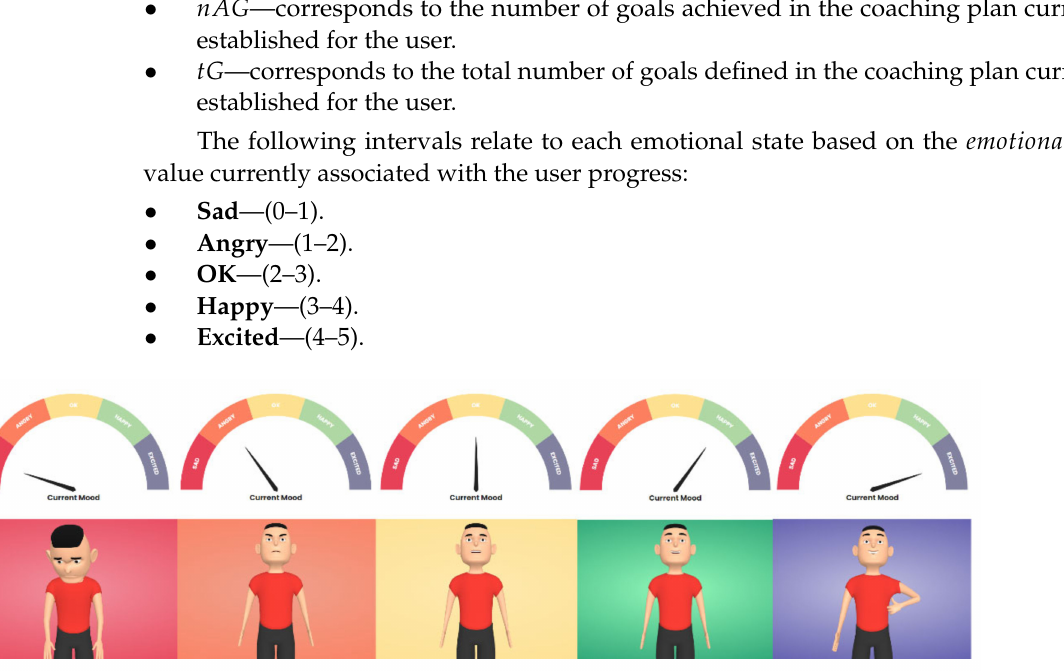
Figure 4. Representation of the five different emotional states of the cognitive